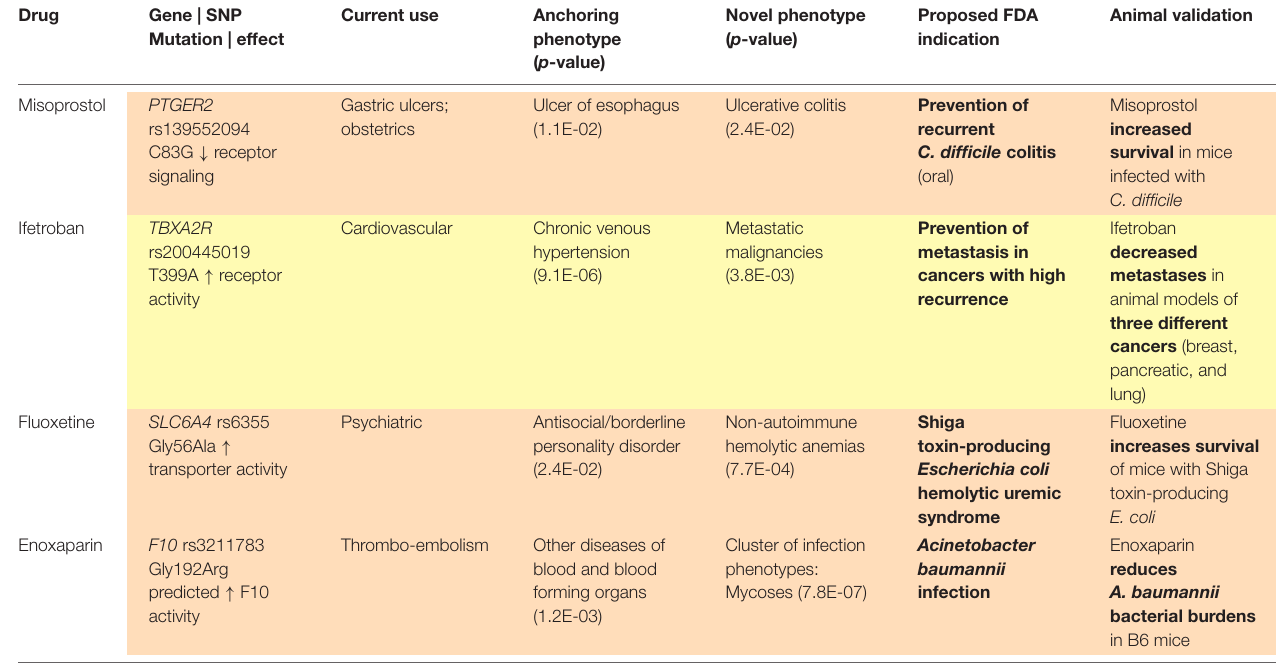
TABLE 1 | Example projects, Vanderbilt University Medical Center Drug Repurposing